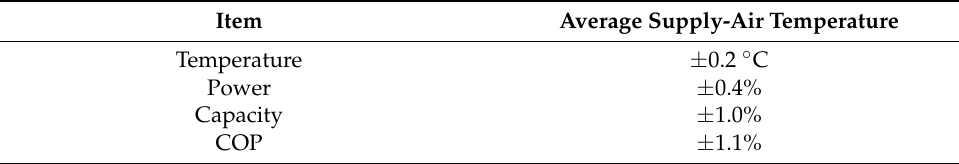
Figure 2. Pictures for the test apparatus: ( a ) indoor unit; ( b ) indoor air tunnel; ( c ) outdoor unit; ( d ) heater. Table 1. Uncertainties of measured and derived items in this research.